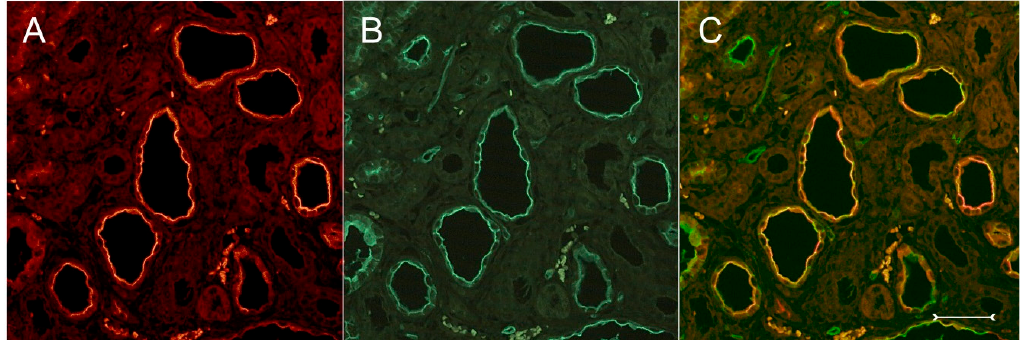
Figure 6. Double fluorescent labeling with anti-Kim-1 (( A ), red) and anti-aquaporin-1 antibodies (( B ), green); merged view in ( C ) of cystically-dilated structures which, are descending thin limbs or distal portions of S3 proximal tubules. They show signal overlap in many profiles in the apical rim; view of outer stripe, (cy/+) kidney. Bar = 30 µm.